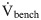
The relationship between apnea-onset time difference and apnea duration for apneas detected correspondingly in both bench airflow and polygraph nasal airflow (149 apneas).Tapnea-bench: duration of apneas detected in bench airflow (V˙bench). Tapnea-source: duration of apneas detected in polygraph nasal airflow (V˙source). Tonset-bench: the apnea onset time of apneas detected in V˙bench. Tonset-source: the apnea onset time of apneas detected in V˙source.